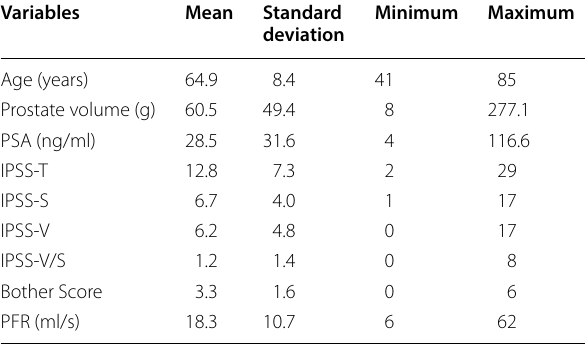
Table 1 Baseline characteristics of the study population